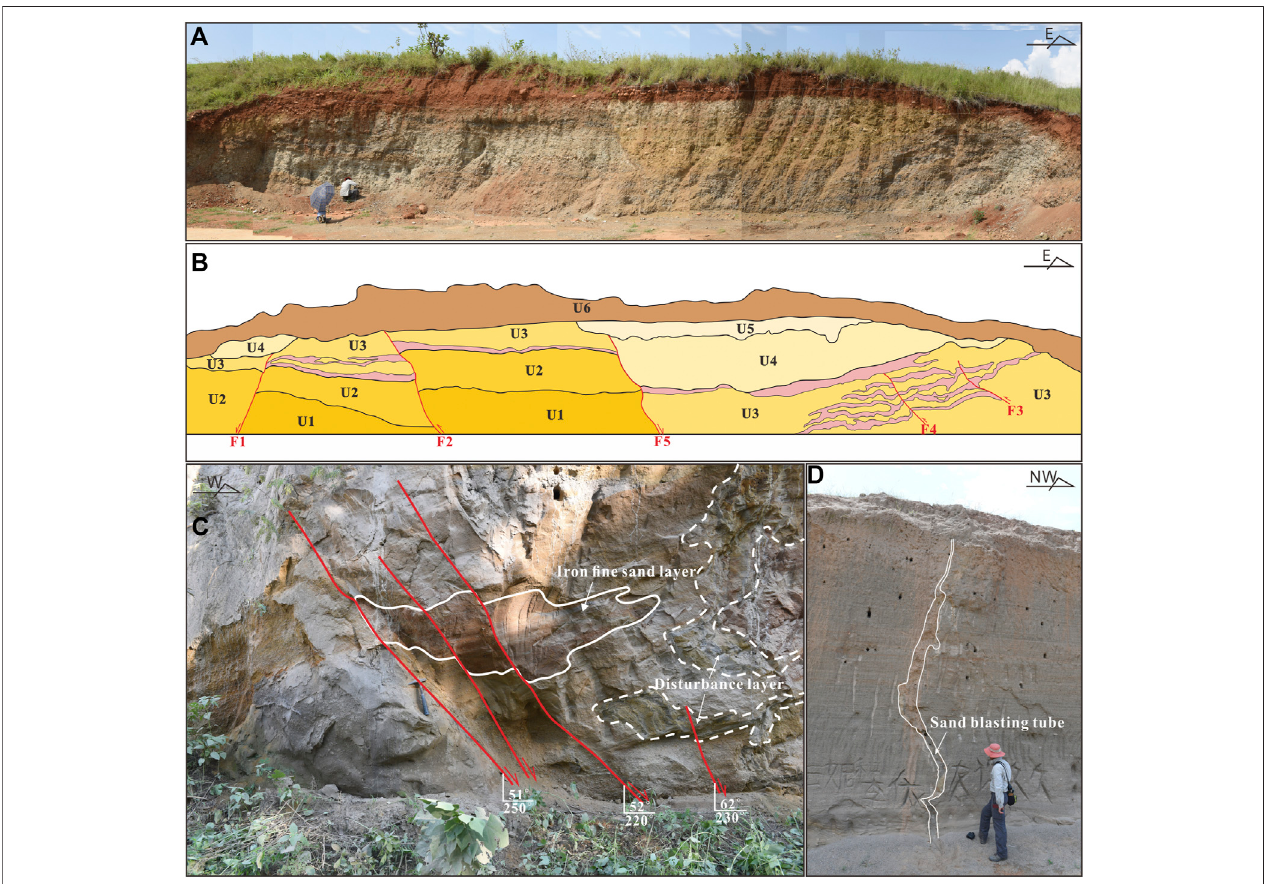
FIGURE 5 | Earthquake-induced effects in different sedimentary units (see the locations in Figure 1 ). (A) Small faults in Q 1al ; (B) the interpretation of (A) , U1: gray gravellayer; U2:lightgrayish-greengravellayer;U3:inter-beddingofgraygravellayerandbrowngray fi nesiltysandbearing gravel;U4:yellow-brownsandlayerbearing gravel; U5: off-white calcareous consolidated gravel layer; U6: eolian brownish-red gravel layer (lower) and sand layer bearing gravel (upper); (C) Small faults and disturbance layer in Q 2al brownish-yellow fl uvial sand layer, the marker layer of afaultdislocation isan iron fi ne sand layer; the lime-green sand layer was disturbed; (D) sandblasting tube in Q 2l medium-coarse lacustrine sand, the walls of the tube are calcareous